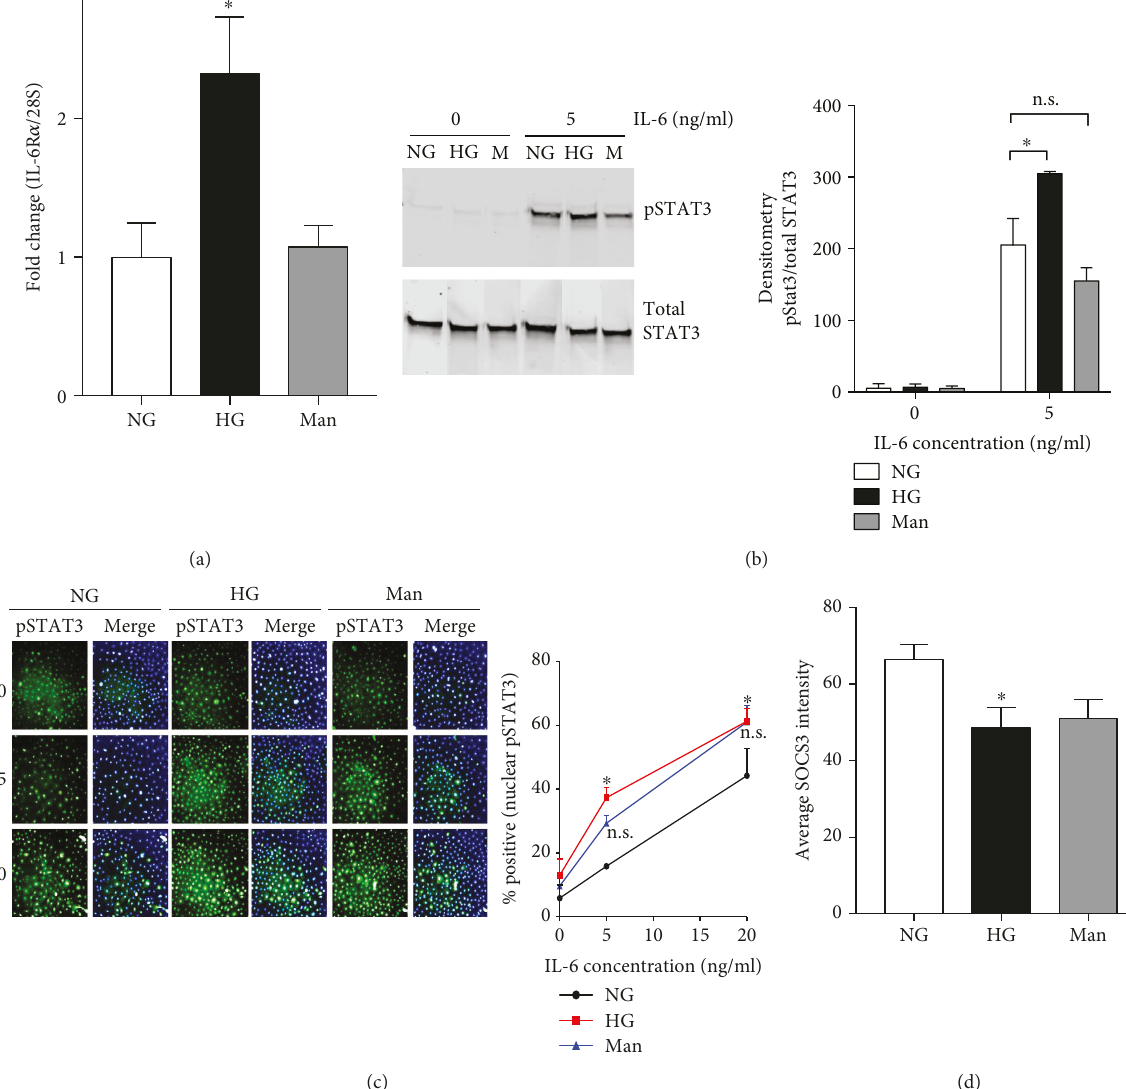
Figure 4: High glucose alters STAT3 activation in cultured keratinocytes. Neonatal mouse keratinocytes (MEKn) were cultured for 7 days in either normal glucose (NG; 5mM), high glucose (HG; 25mM), or mannitol osmotic control (Man; 5mM glucose + 20mM mannitol). (a) Basal IL-6R α mRNA expression was determined via qPCR. Data are presented as the means ± SD ; n = 6 (3 replicates × 2 experiments). (b) MEKn were incubated with 0 or 5ng/ml of rmIL-6 for 30 minutes. STAT3 phosphorylation (Y705) was determined via Western blotting (left panel) and quanti fi ed via densitometry analysis (right panel). (c) MEKn were treated with 0, 5, or 20 ng/ml of rmIL-6 for 30 minutes and stained for pSTAT3 (Y705) (green) and nucleus (blue). (d) MEKn were stained for SOCS3. Percentage of positive staining for pSTAT3 or SOCS3 was determined Operetta High-Content Imaging System (PerkinElmer, Waltham, MA) and analyzed with Columbus (v2.6.0, PerkinElmer). Data are presented as the means ± SD ; n = 3 . ∗ p < 0 05 and ∗∗ p < 0 01 , signi fi cantly di ff erent from normal glucose-treated